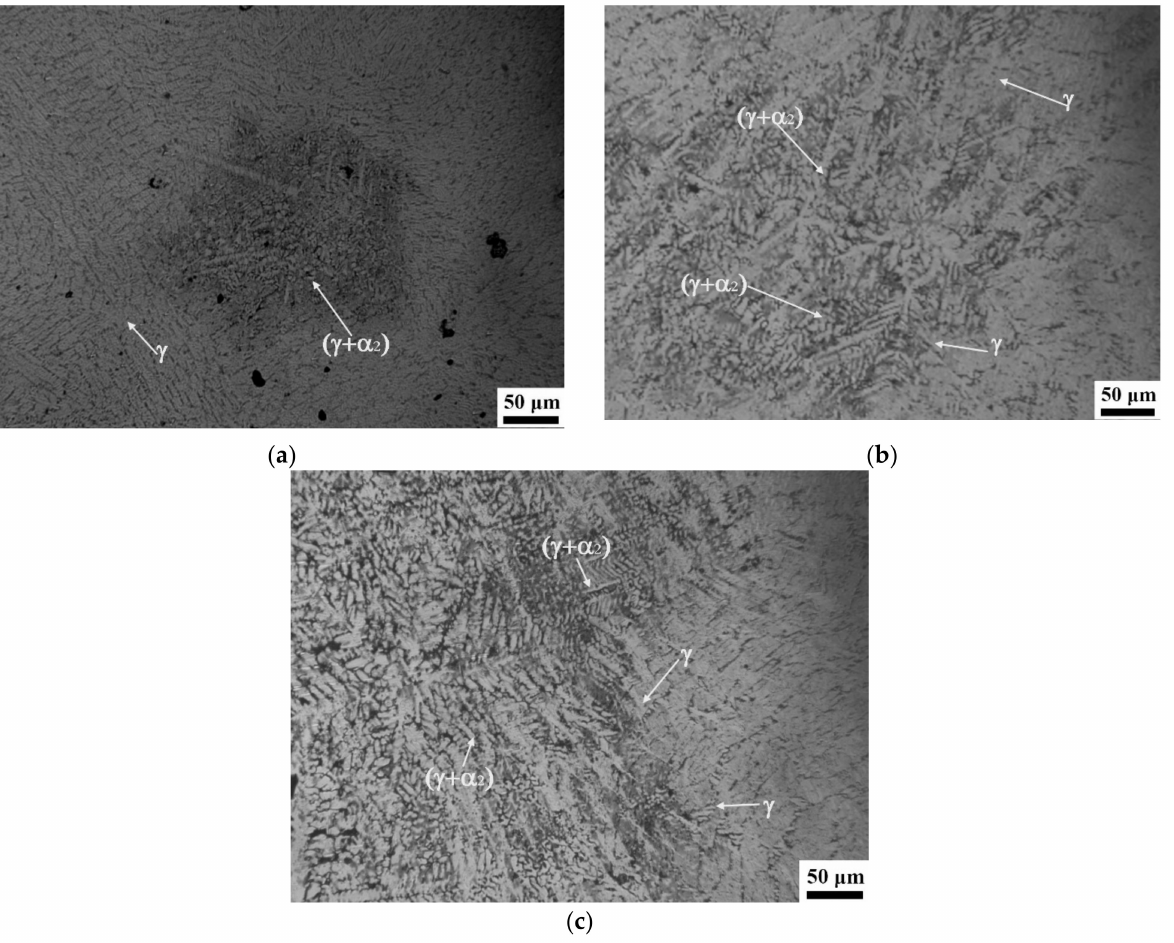
Figure 5. Optical micrographs of as-cast TiAl 46 Cu x specimens: ( a ) TiAl 46 Cu 3 , ( b ) TiAl 46 Cu 4 , and ( c ) TiAl 46 Cu 5 .